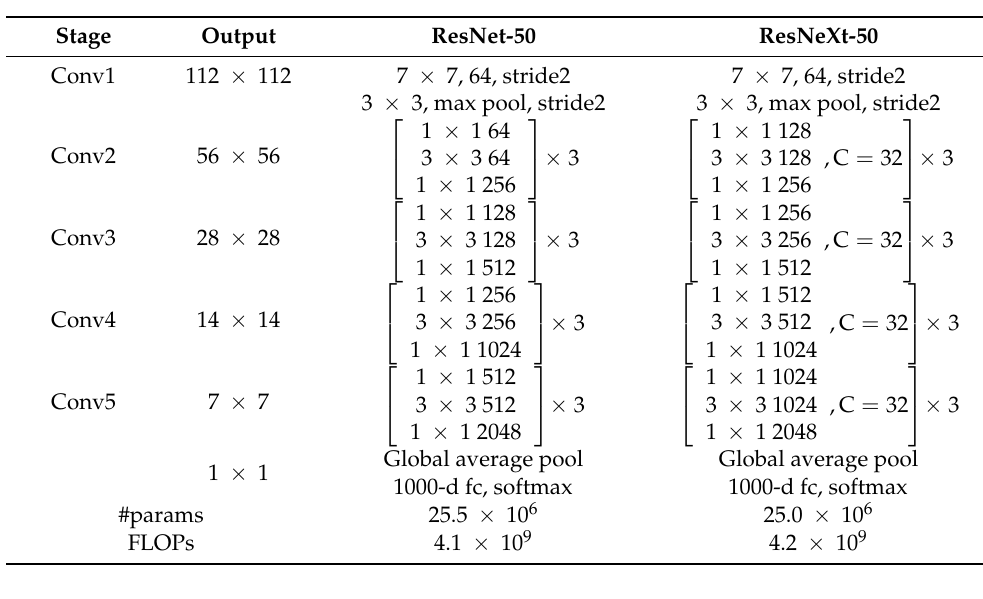
Table 1. Feature extraction network structure comparison